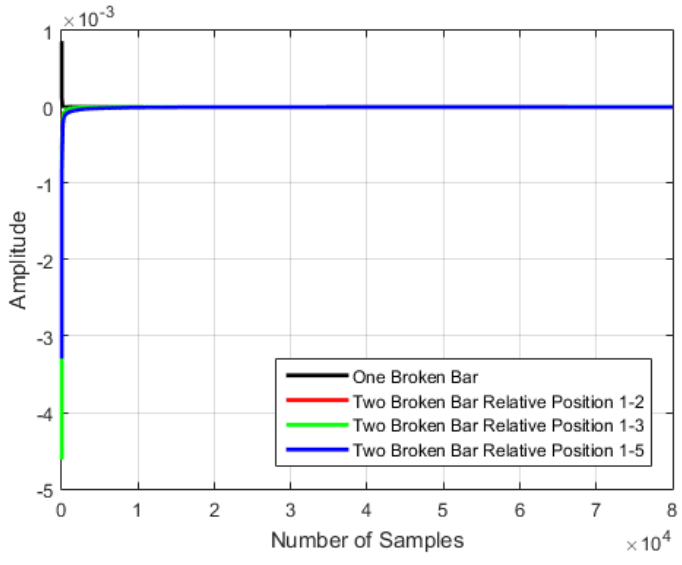
Figure 21. Spectral pattern obtained from the application of the proposed pattern recognition algorithm showed in Figure 3, to identify broken bars.